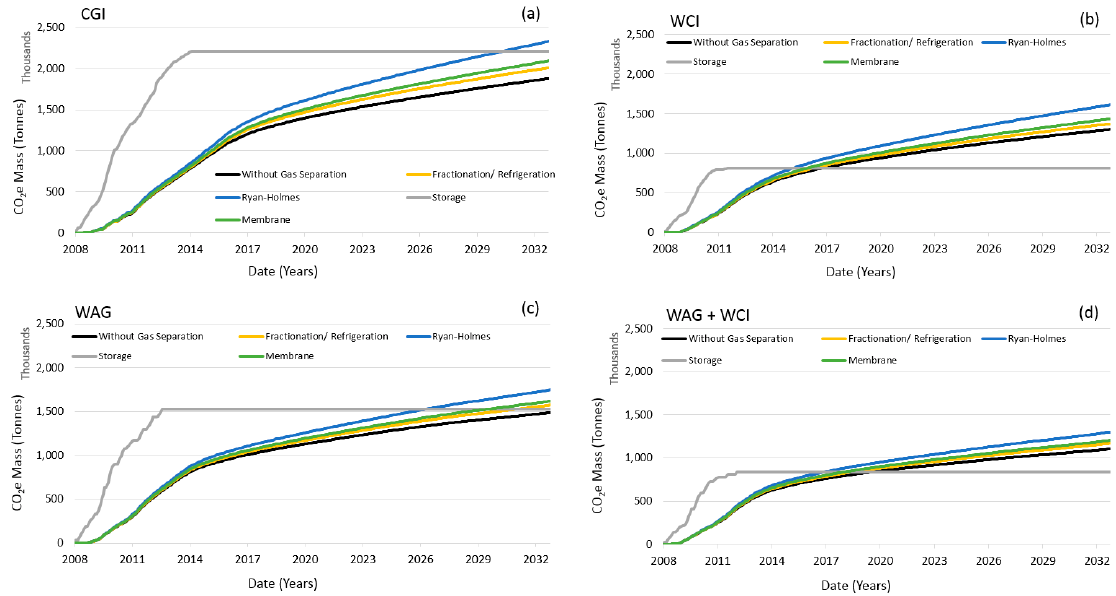
Figure 8. CO 2 storage (gray curves), including storage of excess recycle volumes into an underlying saline aquifer, versus CO 2 e emissions (colored curves) of the gate-to-grave CCUS system. ( a ) continuous gas injection, ( b ) water curtain injection, ( c ) water-alternating-gas, and ( d ) the hybrid scenario.